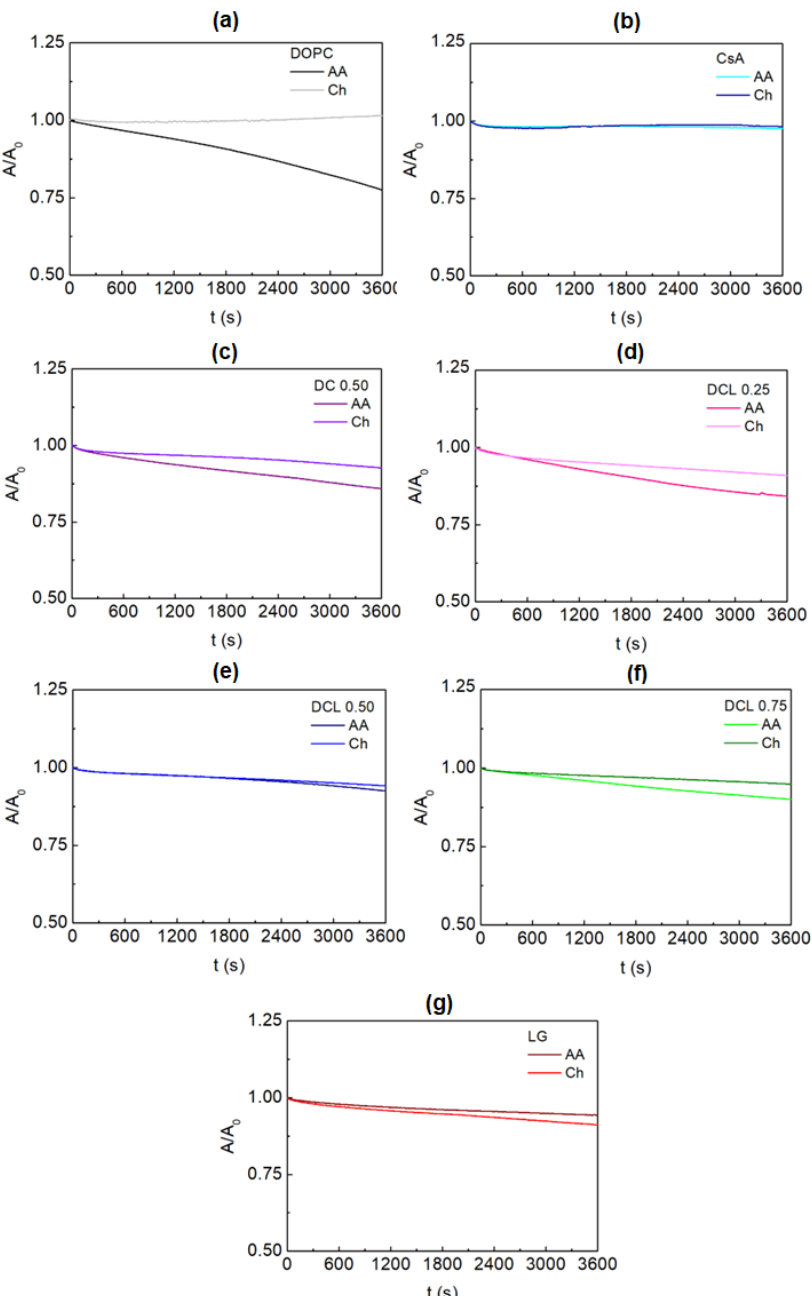
Figure 2. Relative molecular area ( A / A 0 ) changes during the one-hour stabilization at 10 mN m − 1 with the barrier speed of 5 mm min − 1 for DOPC ( a ), CsA ( b ), DOPC-CsA 0.50 ( c ), DOPC-CsA-LG 0.25 ( d ) DOPC-CsA-LG 0.50 ( e ), DOPC-CsA-LG 0.75 ( f ), and LG ( g ) monolayers.